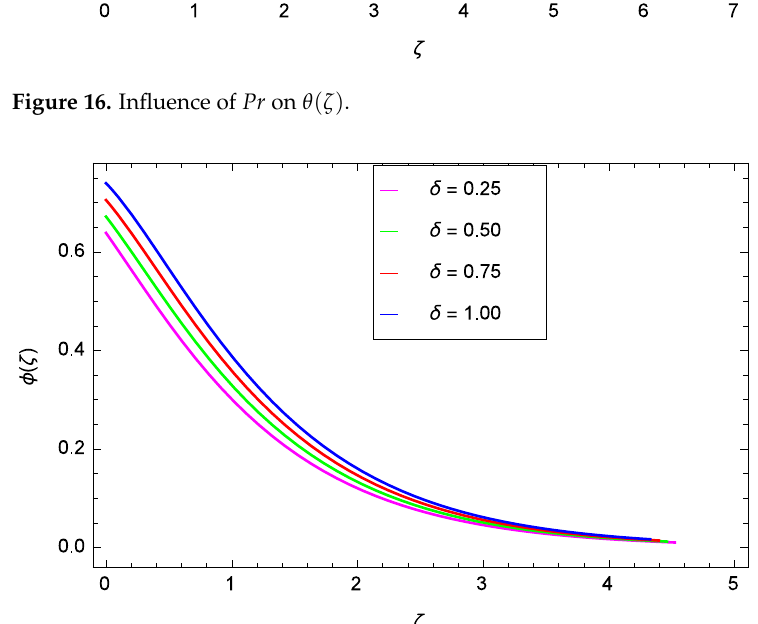
Figure 17. Influence of δ on φ ( ζ )